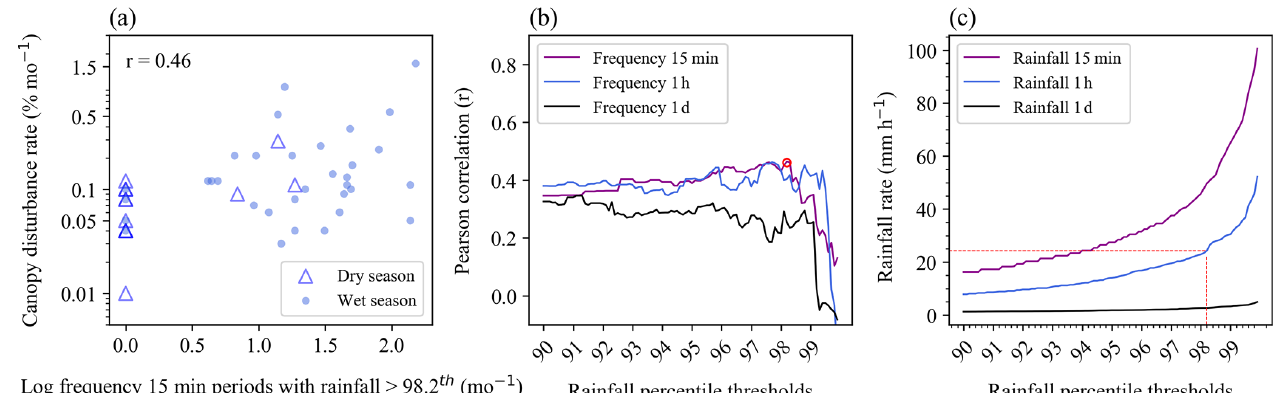
Figure 5. Relation of temporal variation in canopy disturbance rates to the frequency of extreme rainfall events. (a) The relationship for the single best predictor of canopy disturbance rate is the frequency of 15min periods with rainfall exceeding the 98.2th percentile. Each point represents one measurement interval. (b) Variation in the Pearson correlation between the canopy disturbance rate and frequency of extreme rainfall events depending on the temporal grain (colors) and percentile threshold ( x axis) for defining extreme rainfall events. Open red circle represents the best correlation. (c) The relationship of the percentile threshold ( x axis) and rainfall rate ( y axis) for different temporal scales. Dashed red line indicates the rainfall rate in mmh − 1 of the 98.2th percentile.